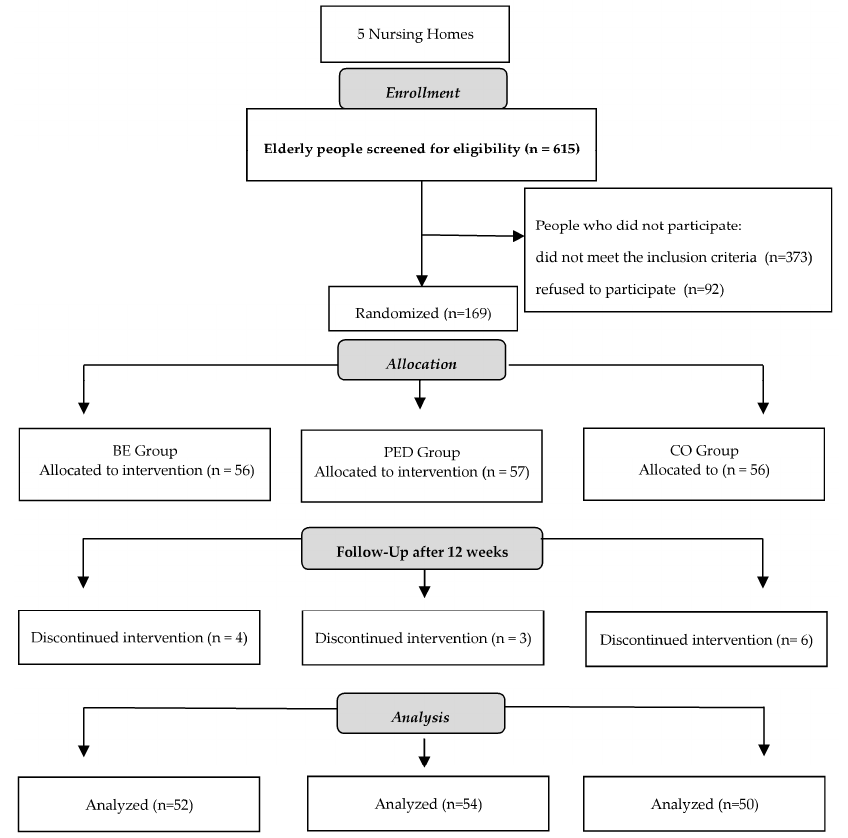
Figure 1. Flow diagram of participants throughout the study.